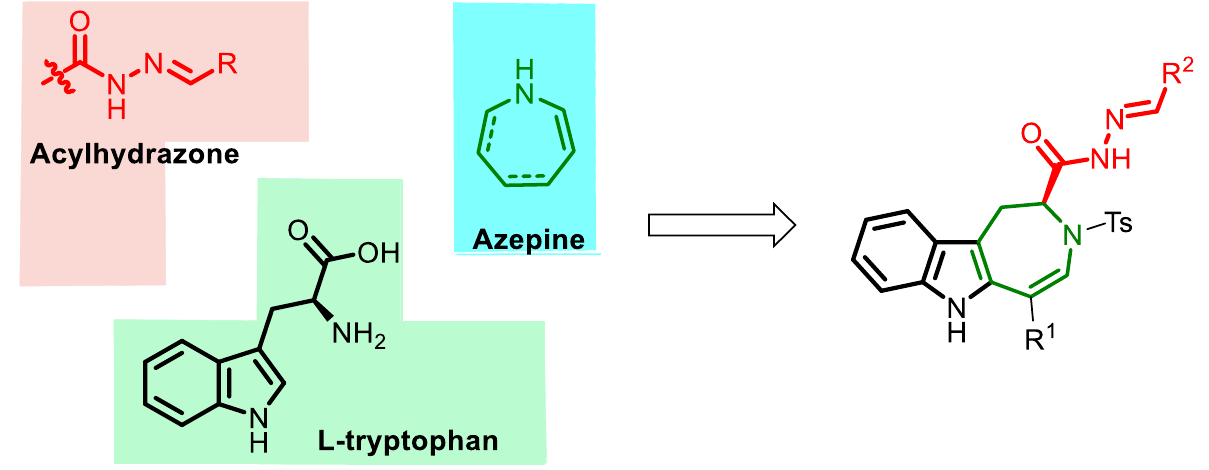
Figure 2. Design of target compounds.